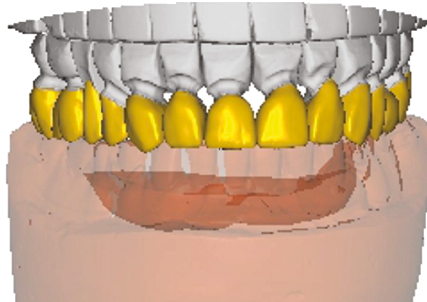
Figure 6: Full contour design of maxillary restorations.